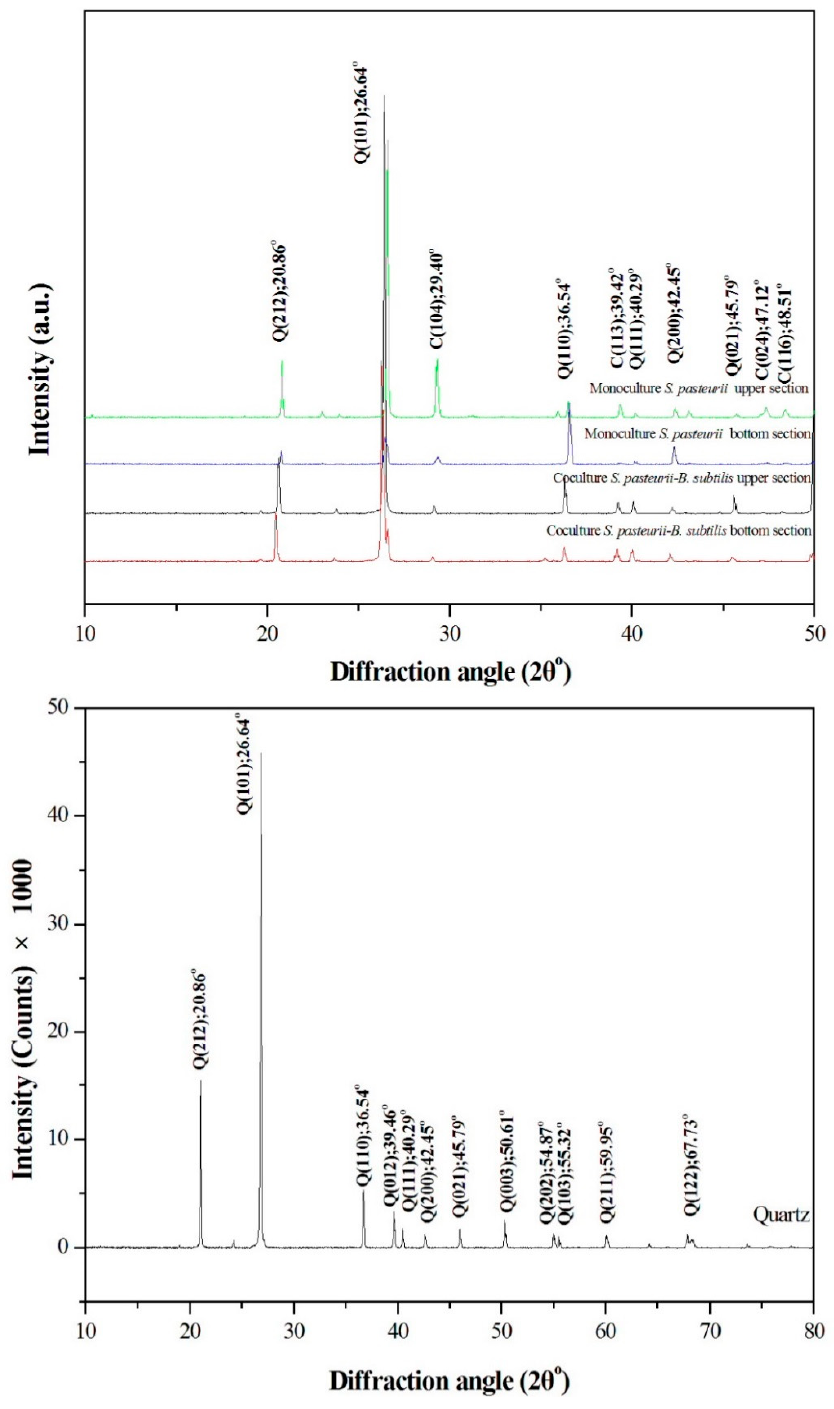
Figure 5. X-ray diffraction of upper and bottom sections for monoculture, coculture. The XRD of quartz only was measured for comparison.